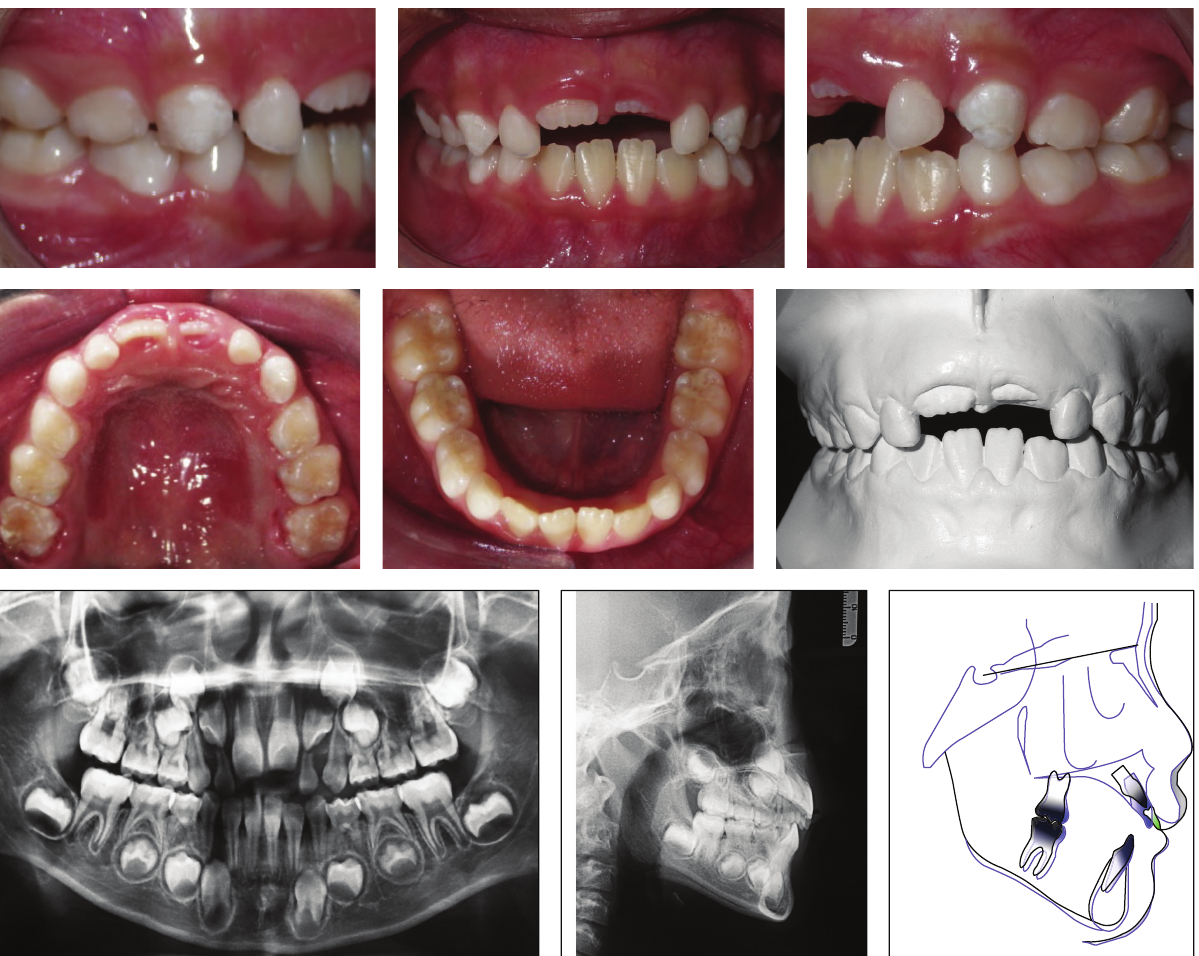
Figure 4: Postexpansion intraoral photographs, radiographs, and cephalometric superimposition. Black, initial; blue,